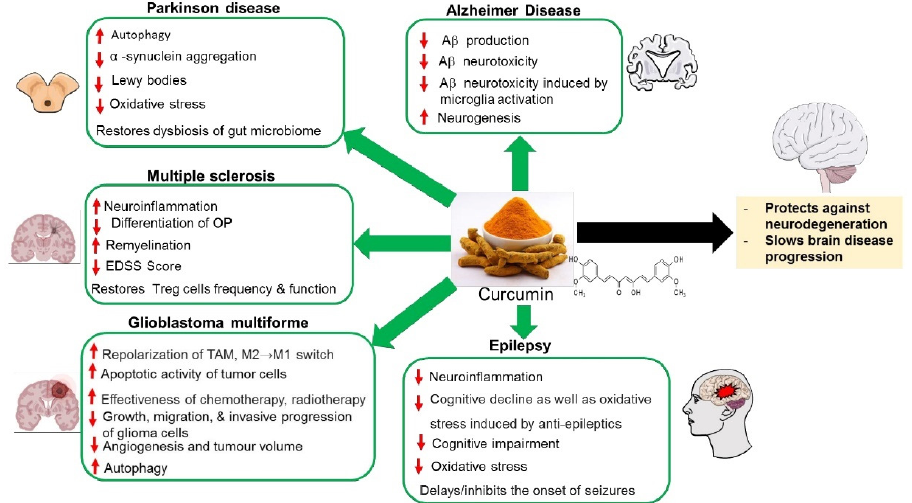
Figure 1. The neuroprotective effects of curcumin against neurological disorders and associated symptoms. TAM: tumor-associated macrophages; OP: Oligodendrocye progenitor; EDSS: The Expand Disability Status Scale.